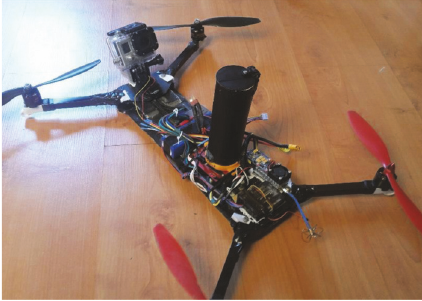
Figure 7: Ready-to-fly drone.